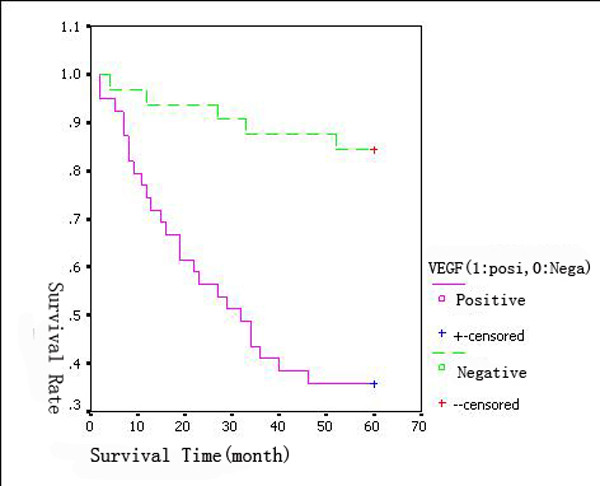
Impact of VEGF expression on the patients' overall survival (log-rank test). The survival time of patients with VEGF positive expression was significantly shorter than that of patients with negative expression.